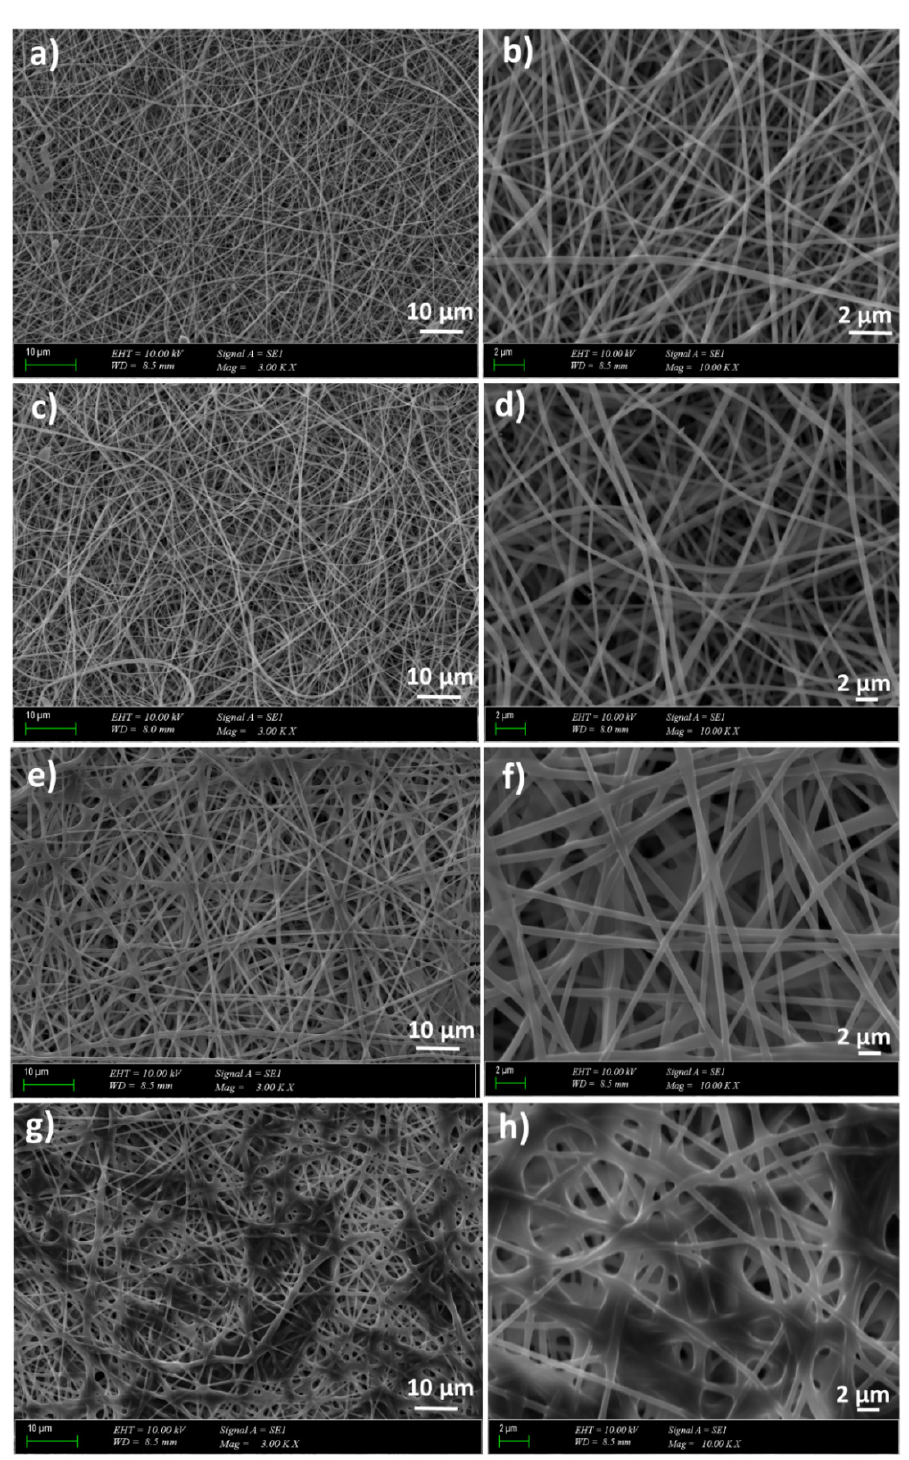
the 13 wt.% PVA/0.5 wt.% GEL/5 wt.% Ps also had thicker diameters compared to the non-crosslinked 13 wt.% PVA and 13 wt.% PVA/(0.5, 1, and 3)wt.% GEL nanofiber patches.